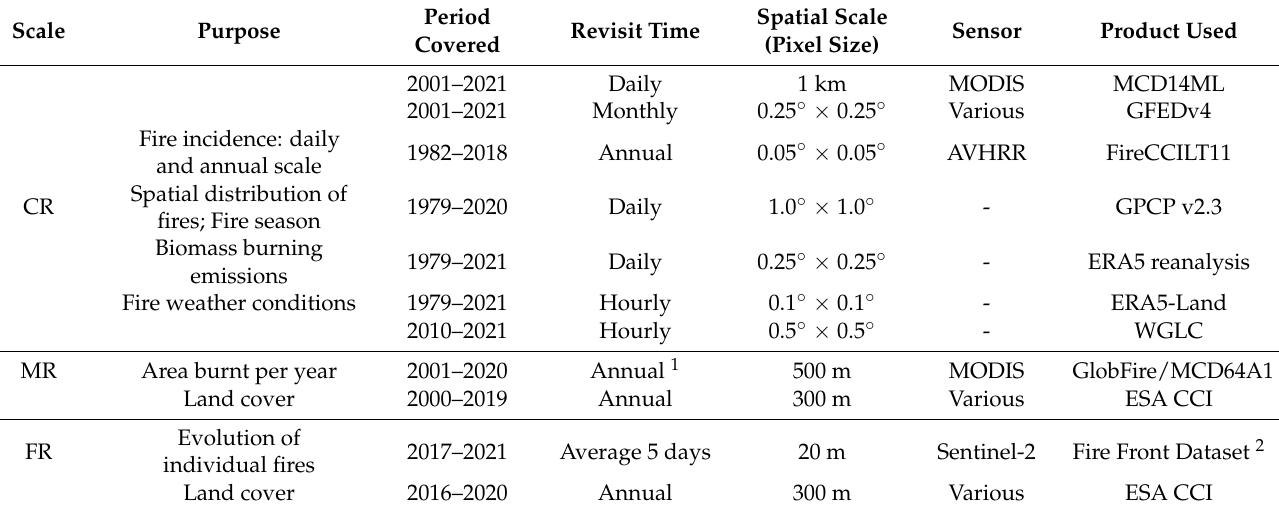
Table 1. Overview of the three scales (coarse resolution, CR, medium resolution, MR, and fine resolution, FR) of the fire analysis and the associated data used.